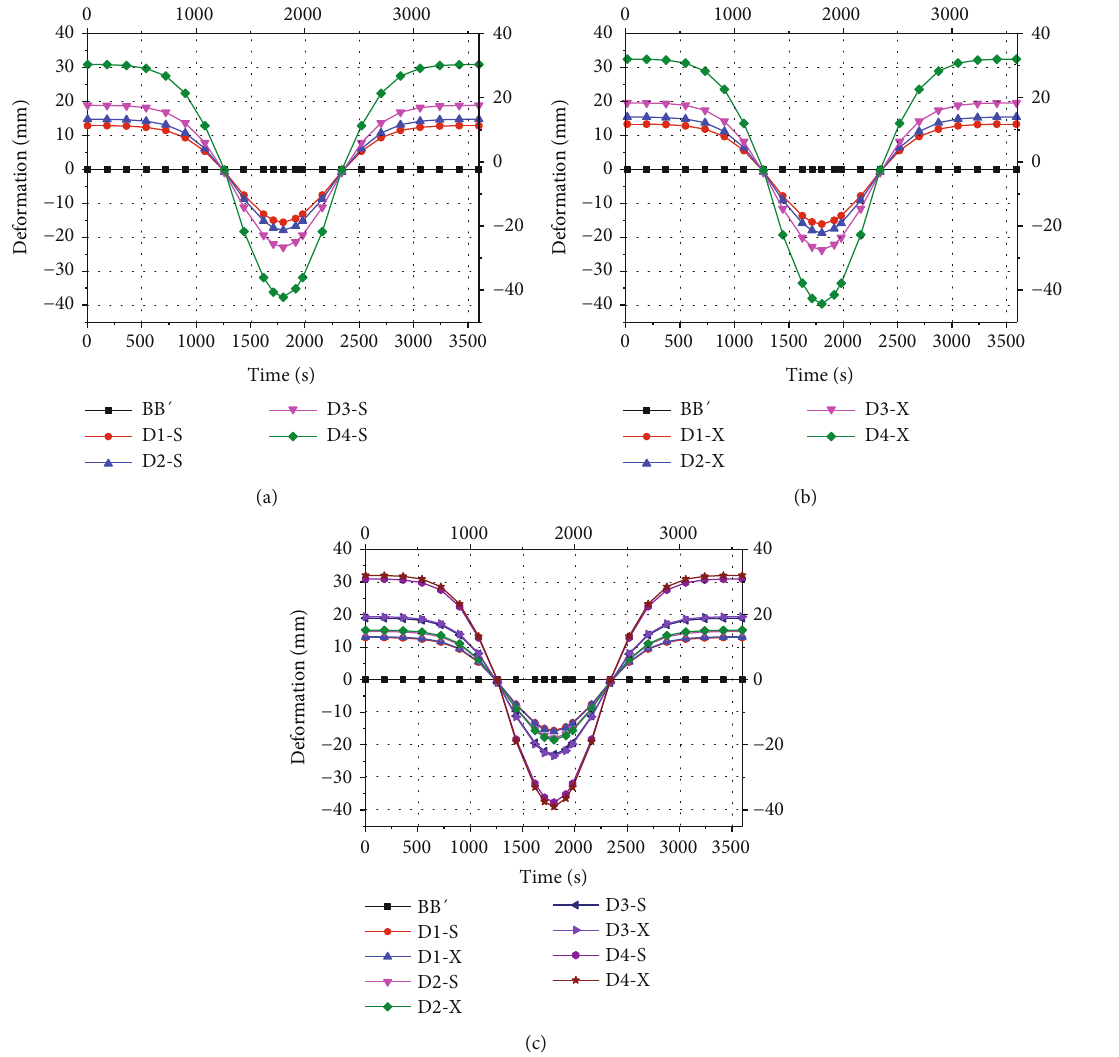
Figure 10: Time history deformation curve at key points of antenna structure. (a) The upper rods. (b) The lower rods. (c) The upper and lower rods.